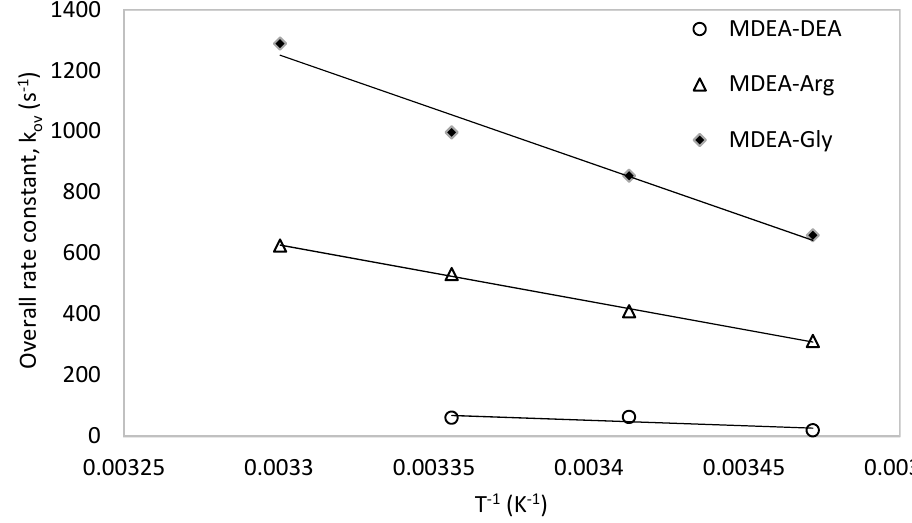
Figure 13. Comparison of MDEA-Arg with other MDEA blends.